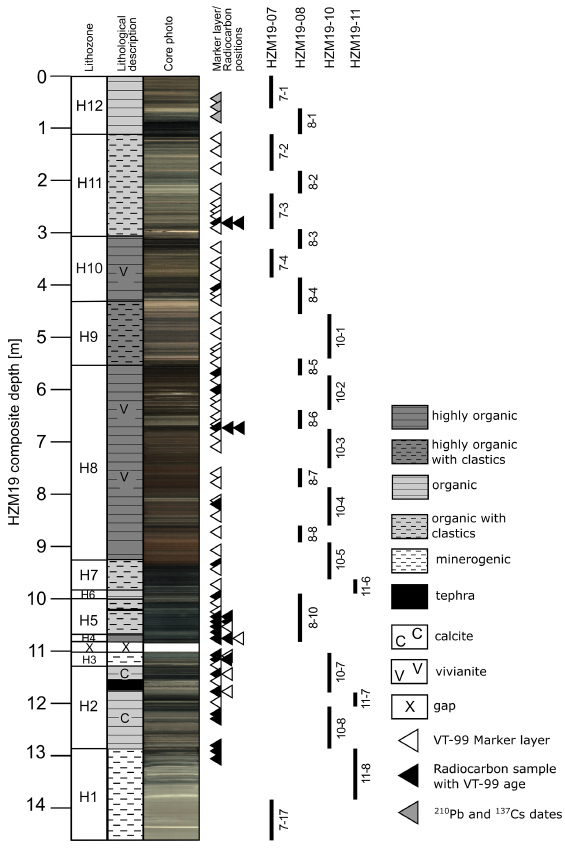
Figure 2. Composite profile of HZM19 with (from left to right) lithozones H1 to H12 (see Table A1), lithological description, core photography taken immediately after core splitting, positions of marker layers and radiometric samples (see Tables A5 and A7), and core sections used for the composite profile (see Table